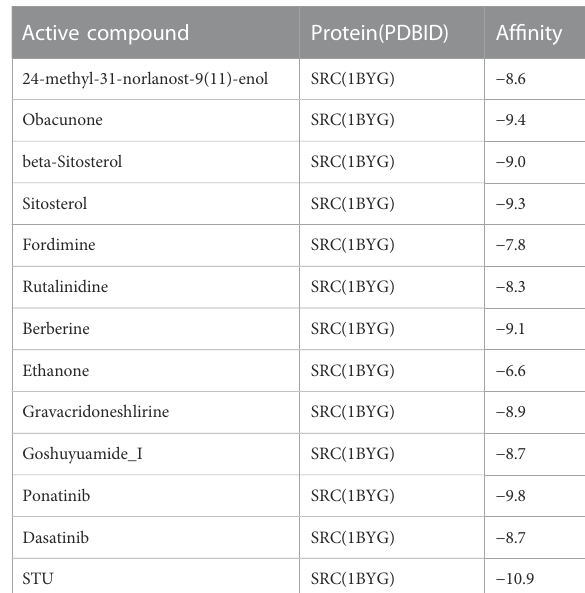
TABLE 5 The af fi nity of compounds with SRC(1BYG) (kcal.mol − 1